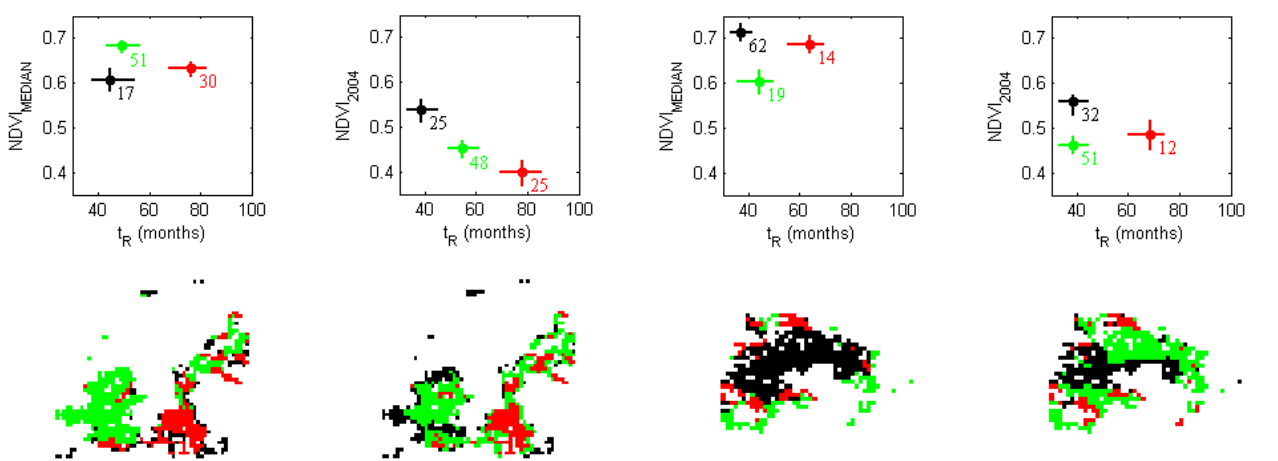
Fig. 8. Dispersion diagrams (upper panels) and spatial distribu- tion (lower panels) of centroids as obtained from K-means clus- tering performed on pairs { t R , NDVI MEDIAN } (left panels) and { t } with respect to pixels over the large fire scar located R , NDVI 2004 in Region I. Clusters are coloured black, red and green by decreas- ing values of the NDVI MEDIAN (left panel) and NDVI 2004 (right panel) of the respective centroids. Coordinates of the centroids are identified by filled circles in the dispersion diagrams, whereas hor- izontal and vertical bars indicate the interquartile ranges. Integer numbers next to each centroid indicate the fraction of areal cover- age (%) by each cluster.